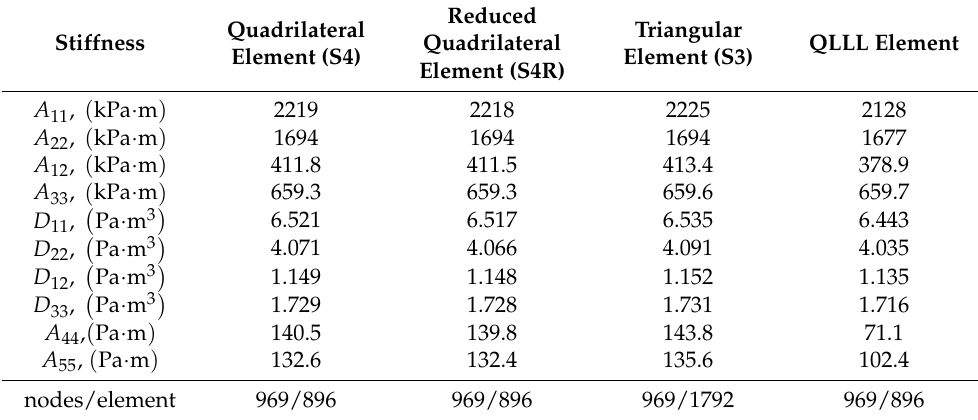
Table 3. The stiffnesses of the representative shell element computed for different element type- sine geometry.